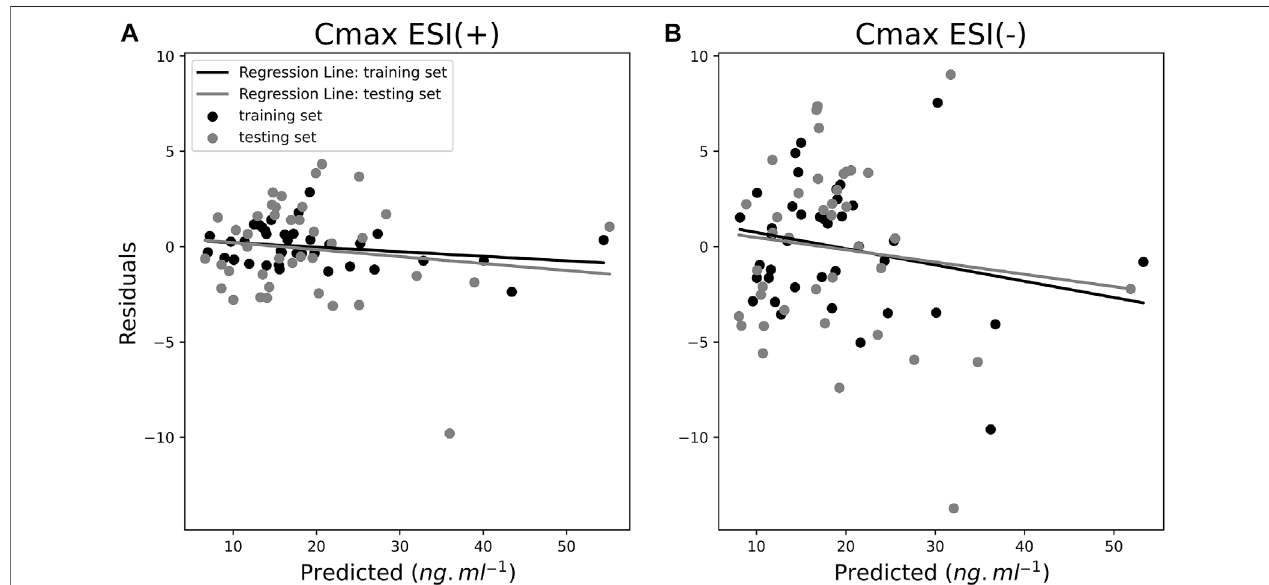
FIGURE8| ResidualplotsofESI (+) (A) and ESI ( − ) (B) maximum plasma drugconcentration( C max )models forboth training (black dots) withleave-one-outcross- validation (LOOCv) testing samples (gray dots) as dispersion diagrams.